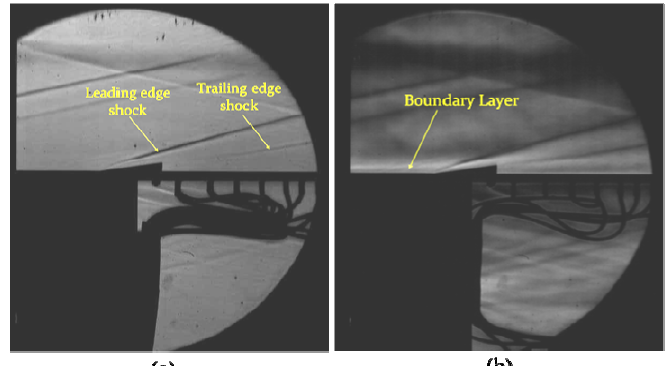
Figure 7. Schlieren images for model MR80. Normal schlieren ( a ) and high-speed schlieren at 10,000 fps ( b ) from Saad et al. [22] (Reprinted with permission of the American Institute of Aeronautics and